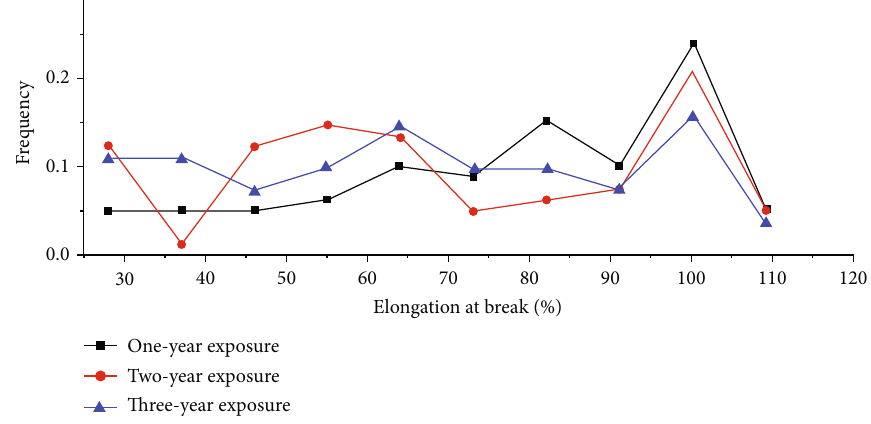
Figure 8: Elongation at break of all samples after the exposure